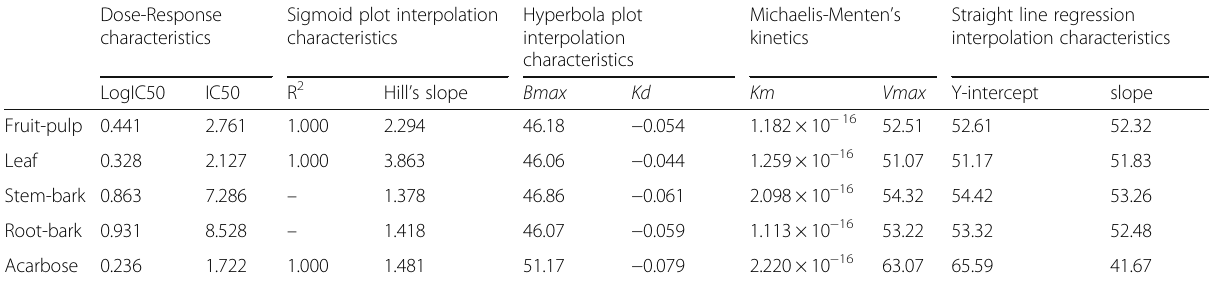
Table 5 Dose-response characteristics of the influence of Annona muricata dichloromethane extracts on α -amylase activity Dose-Response Sigmoid plot interpolation Hyperbola plot characteristics characteristics interpolation characteristics